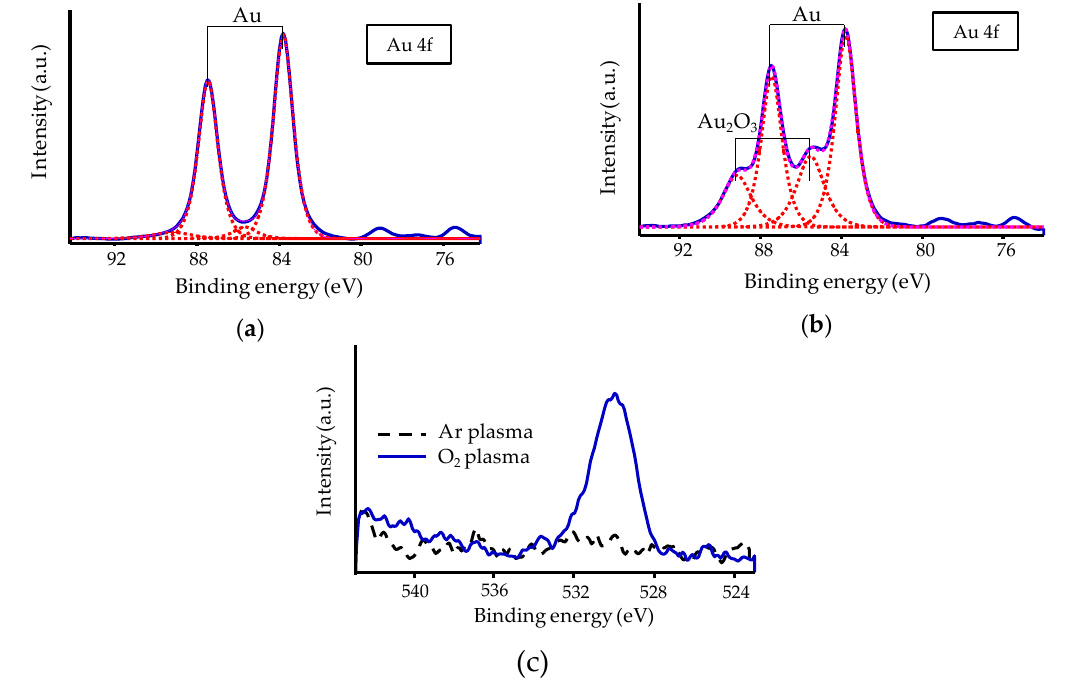
Figure 6. X-ray photoelectron spectroscopy (XPS) spectra of Au surfaces that received different plasma treatments: ( a ) relative peak intensity in the Au 4f region of surface that received Ar plasma treatment; ( b ) relative peak intensity in the Au 4f region of surface that received O 2 plasma treatment; ( c ) relative peak intensities in the O 1s region of surface that received Ar and O 2 plasma